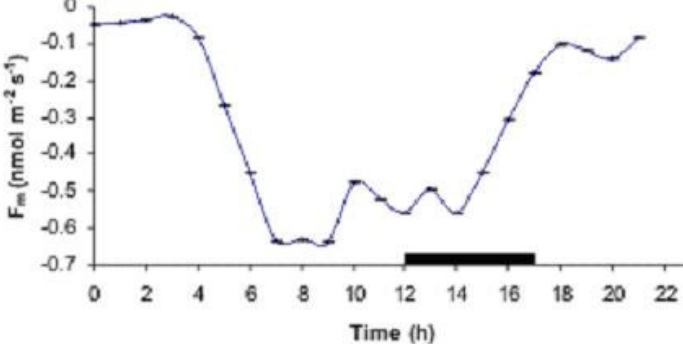
FIGURE 2. Ozone flux to the plasmalemma (F m ), 24-h profile. Vertical bars indicate ± SE. Horizontal thick bar indicates the period of maximum values of ozone. Time is set from 0 to 23 h. n = 24.